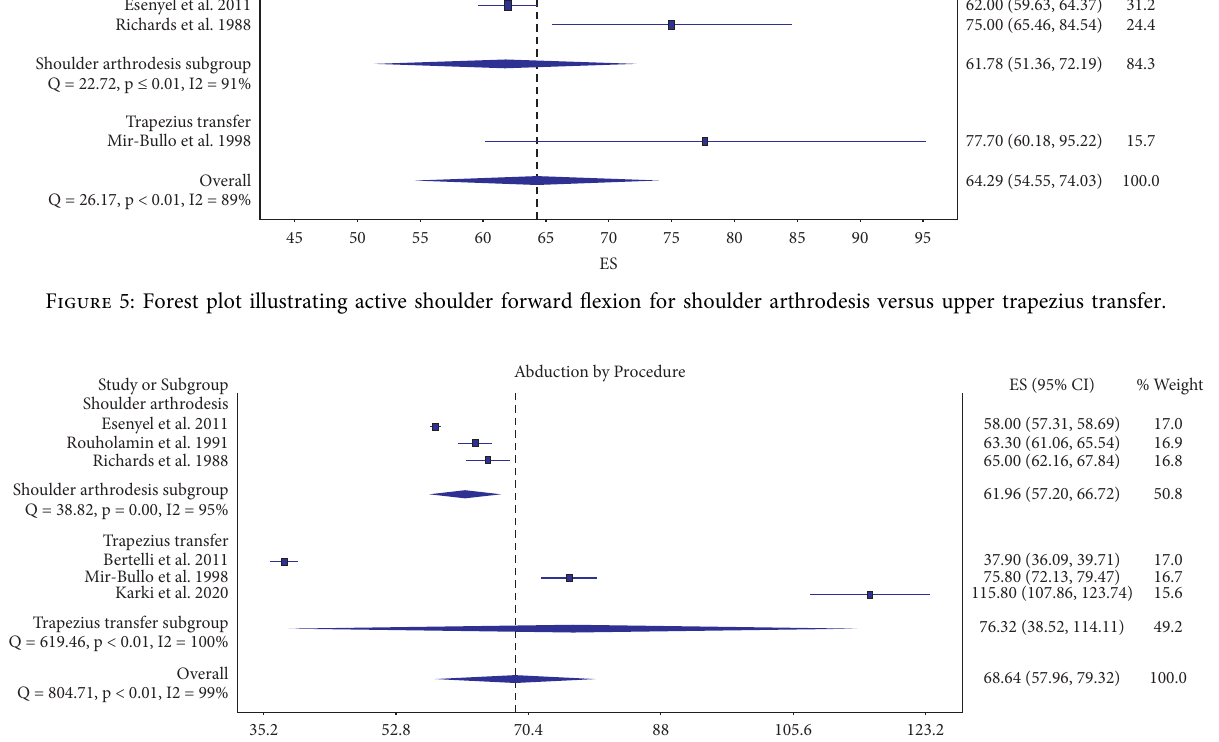
Q = 619.46, p < 0.01, I2 =